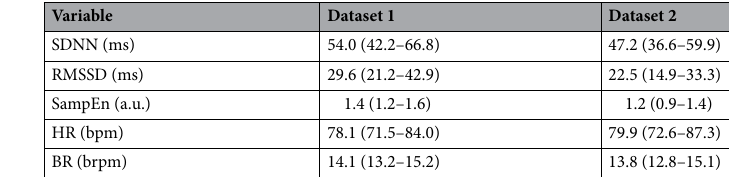
Table 3. Cardiorespiratory and heart rate variability parameters, reported as median with interquartile range. The processing of maternal RR intervals from fetal ECG measurements, as well as the development of